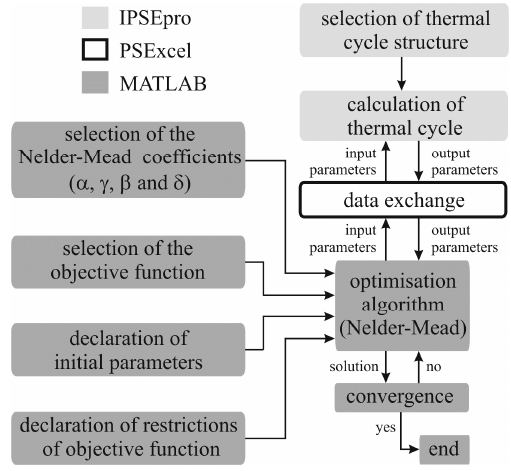
Figure 1. A scheme of the communication between IPSEpro, PSExcel and MATLAB.